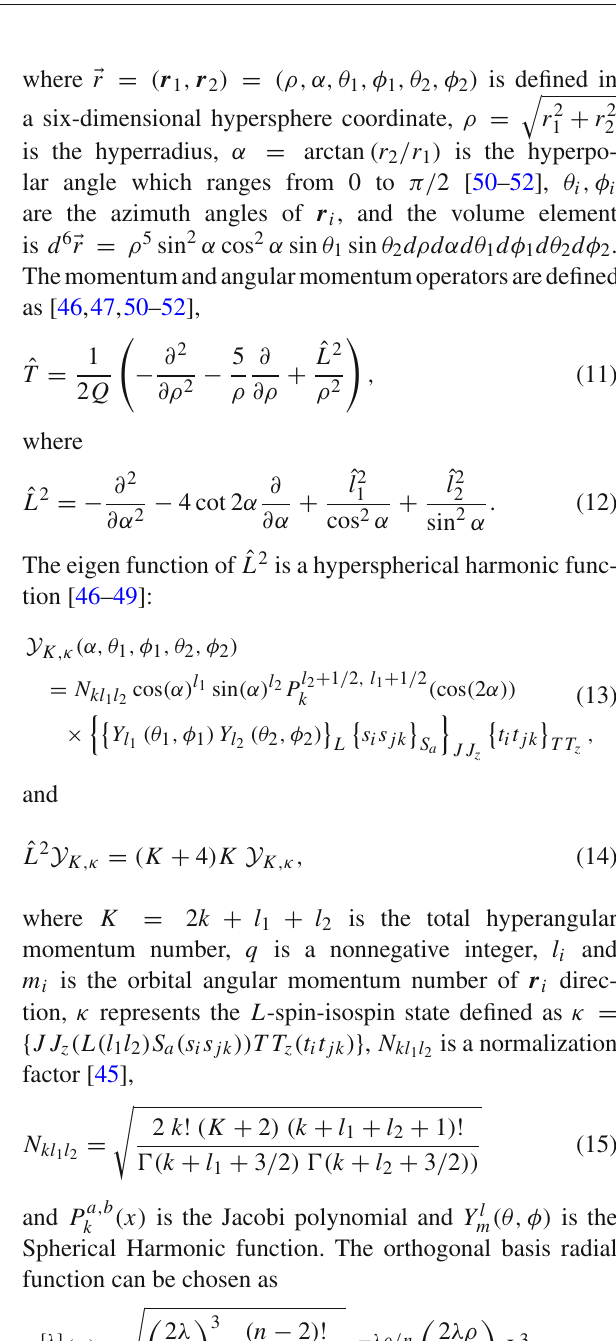
Table 1 g 3 for 3 H , (cid:3) N N and (cid:3)(cid:3) N Nuclei 3 H (cid:3) pn (cid:3) nn (cid:3)(cid:3) p g 3 1/16